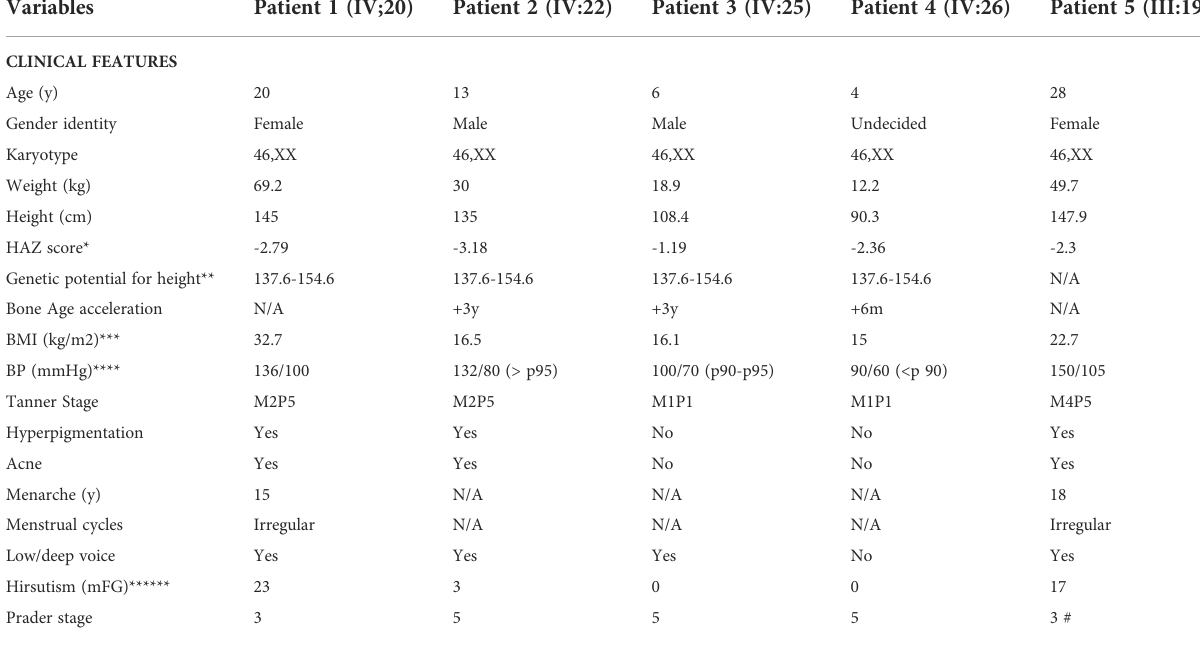
TABLE 1 Clinical characteristics and initial biochemical analysis in a family with CAH due to CYP11B1 de fi ciency.